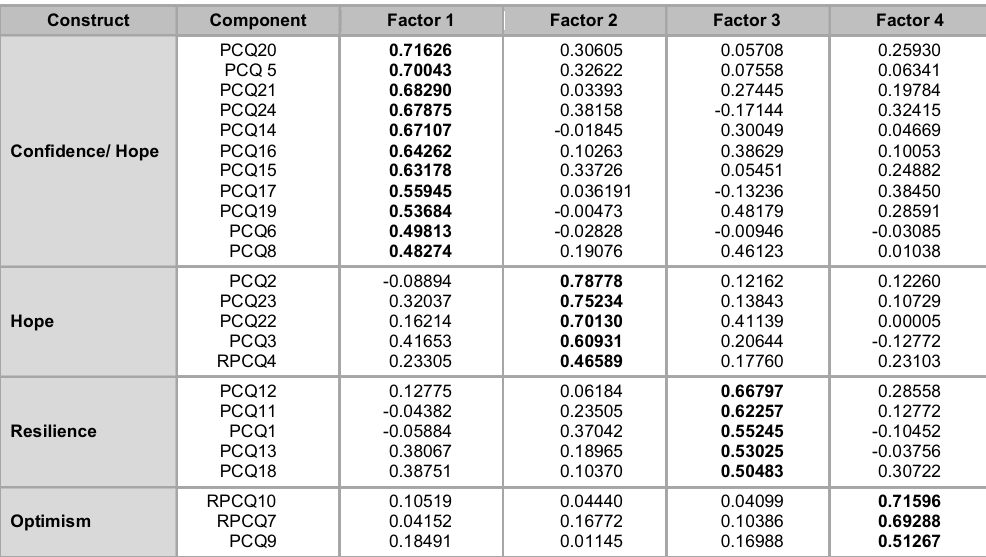
Rotated factor pattern for PSA-PsyCap